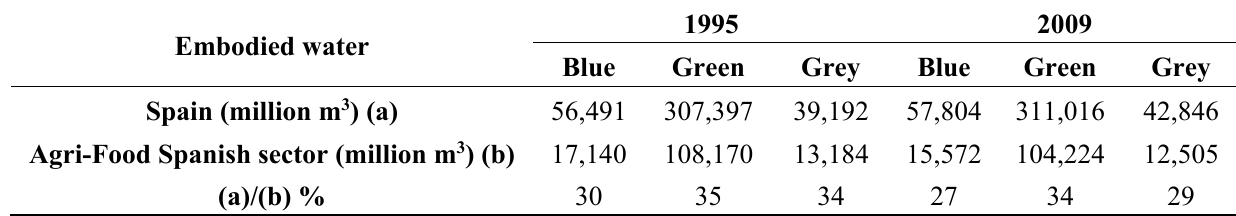
Table 1. Water embodied in the Spanish final demand, million m 3